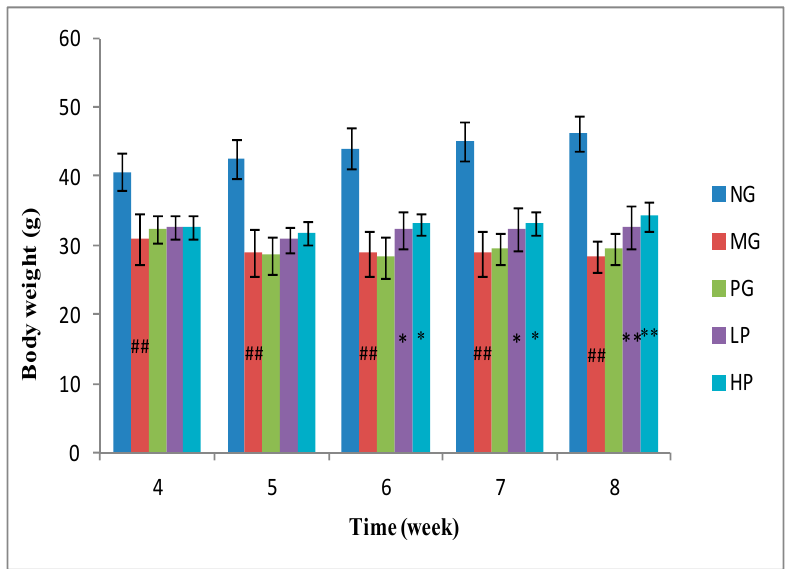
Figure 2. The body weight of mice in 5 weeks after modeling. NG, normal group; MG, model group; PG, positive group; LP, low-dose polysaccharides group; HP, high-dose polysaccharides group. “ ## ” represents very significant difference compared with NG ( p < 0.01); ** represents very significant difference compared with MG ( p < 0.01); * represents significant difference compared with MG ( p < 0.05).